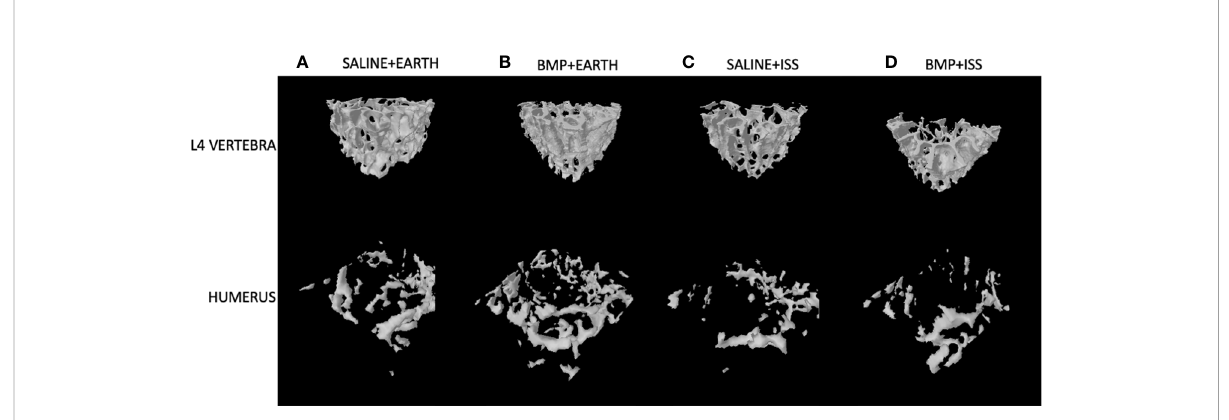
FIGURE 2 Representative 3D µCT reconstructions of the trabecular compartment of vertebral and humeral bone in the following groups: (A) Saline+Earth; (B) BMP+Earth; (C) Saline+ISS; and (D) BMP+ISS. BMP, Bone Morphogenetic Protein 2; ISS, International Space Station; L, lumbar verterbrae; uCT, micro-computed tomography.